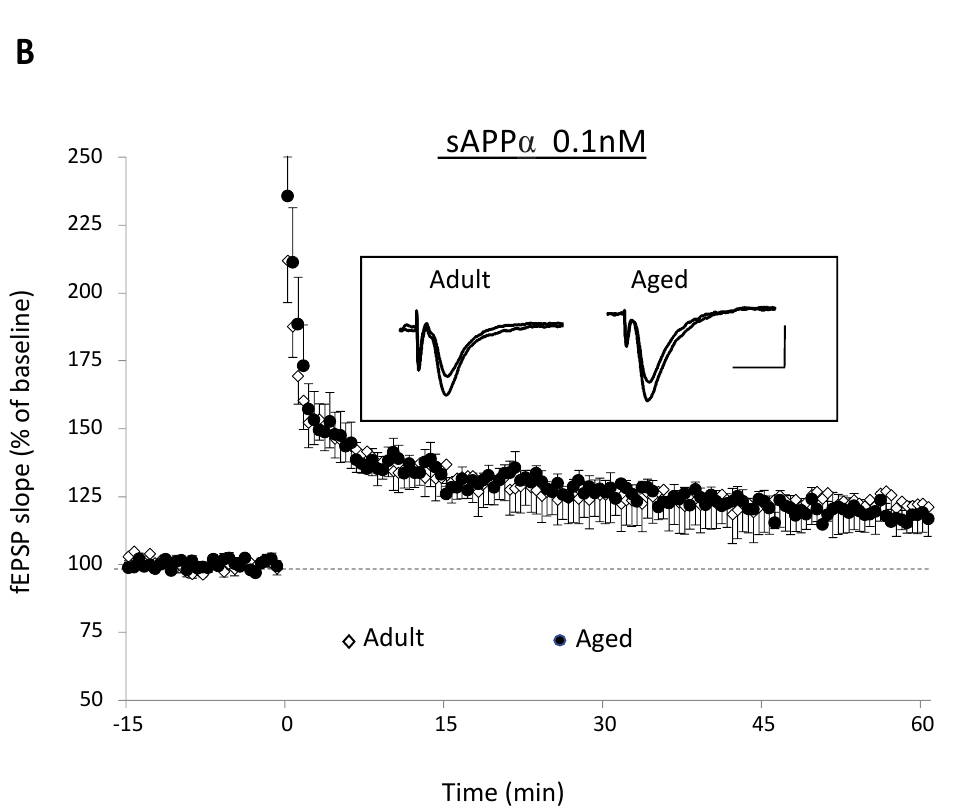
Figure 2. sAPP α rescues the age-related deficit of theta-burst-induced long-term potentiation. ( A ) Time-course comparison of theta-burst stimulation (TBS)-induced LTP in adult (10 slices/7 mice) and aged (12 slices/8 mice) animals in the control aCSF (* for p < 0.05 compared to adult mice two-way ANOVA in 15 last minutes and Bonferroni multiple comparisons test). In the insert are superimposed traces of fEPSPs recorded before and 60 min after TBS in an adult and aged mouse. ( B ) Time-course comparison of TBS-induced LTP in adult (10 slices/5 mice) and aged (10 slices/7 mice) mice in aCSF supplemented with sAPP α (0.1 nM). In the insert are superimposed traces of fEPSPs recorded before and 60 min after TBS in an adult and aged mouse (bars: 20 ms and 0.5 mV).